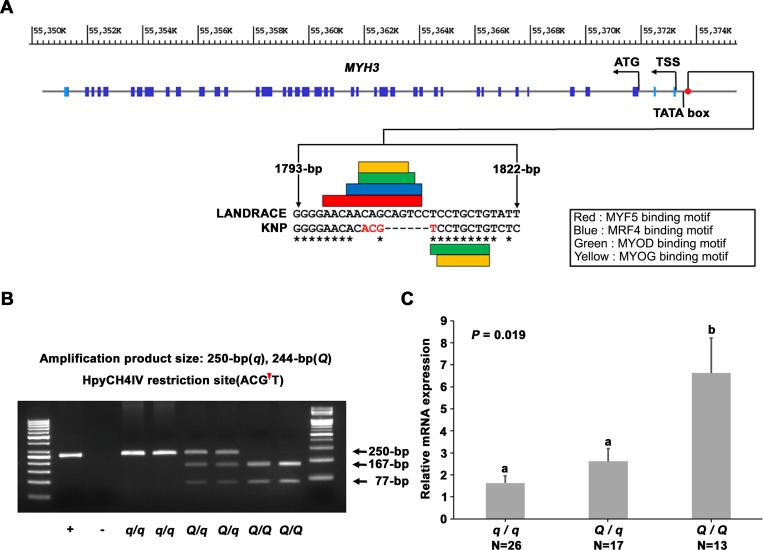
Genomic structure of porcine MYH3, its FSV, and the effect of the FSV on the MYH3 expression.(A) The 2-kb region in the 5′- flanking region from the transcription start site (TSS), coding exons and introns, and the 0.5-kb region in the 3′- flanking region from the stop codon were Sanger sequenced. Light blue boxes represent 5′- flanking region and 3′- flanking region noncoding exons. The positions of the TATA box in the promoter and the TSS are indicated. Dark blue boxes represent coding exons, and the ATG initiation codon is designated. The red dot indicates the position of XM_013981330.2:g.−1805_−1810del. Predicted myogenesis regulatory factor (MRF) binding sites detected in the FSV sequence are presented in the box. (B) Determination of the genotype of the XM_013981330.2:g.−1805_−1810del was conducted by PCR amplification and subsequent HpyCH4IV digestion. The q/q genotype represents the MYH3 homozygous genotype originating from Landrace and Duroc pigs; the Q/Q genotype represents the MYH3 homozygous genotype originating from KNPs. The + and–symbols represent positive and negative controls, respectively. (C) Messenger RNA expression levels for the porcine MYH3 gene stratified by genotype at the XM_013981330.2:g.−1805_−1810del in longissimus dorsi muscle (least square mean±standard error). The significance of the effect of the FSV on gene expression was computed using the general linear model y = μ+g+s+l+e, where y is the relative mRNA expression level, g is the fixed effect of the genotype, s is the fixed effect of sex, b is the fixed effect of line, and e is residual. Different letters above the error bar show significant differences between genotypes (P<0.05).